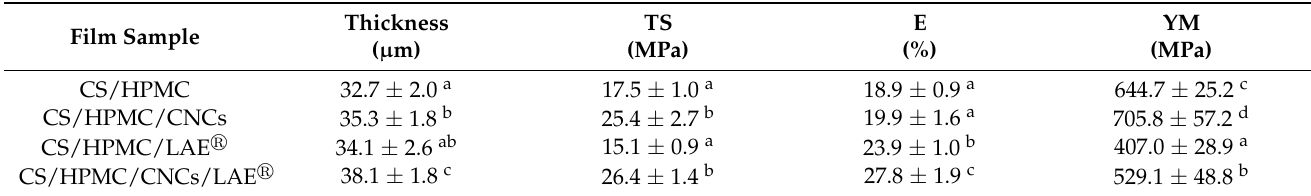
Table 2. Thickness, tensile strength (TS), elongation (E%), and Young’s modulus (YM) of films based on chitosan/hydroxypropyl methylcellulose blend (CS/HPMC) as control and those reinforced with cellulose nanocrystals (CNCs 10% ( w / w ) of biopolymer) and/or enriched with lauroyl arginate ethyl (cid:114) (LAE 5% ( w / w ) of